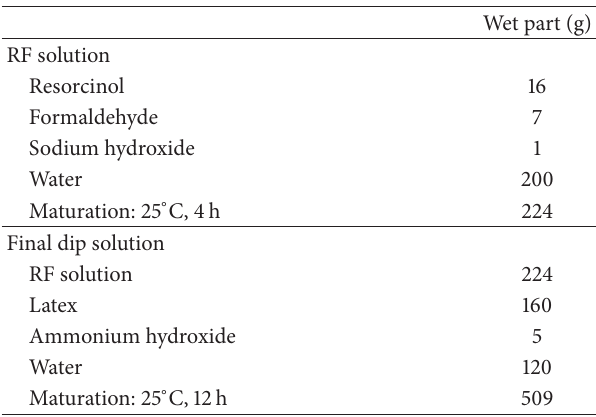
Table 3: Formulation of the RFL primer used in this